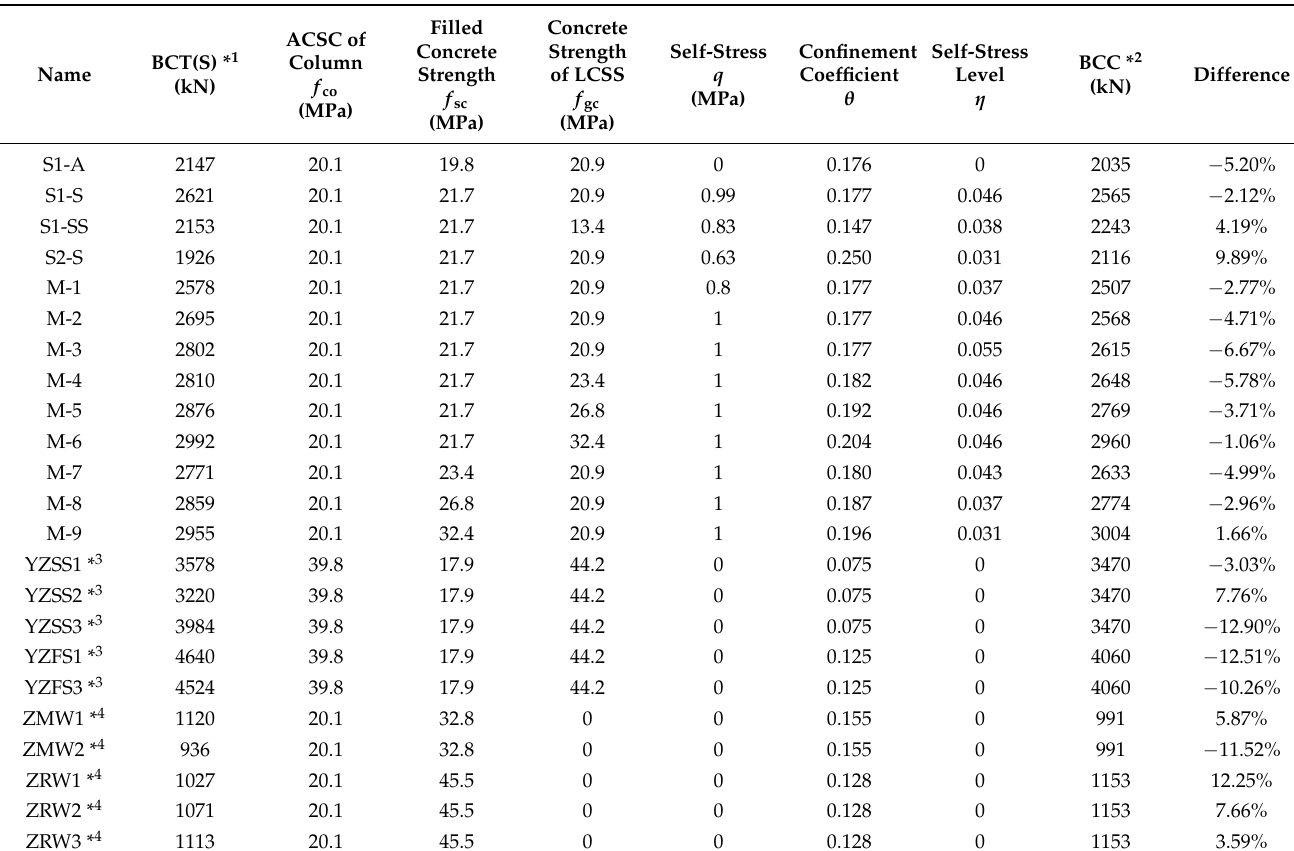
Table 9. Verification results of the fitting